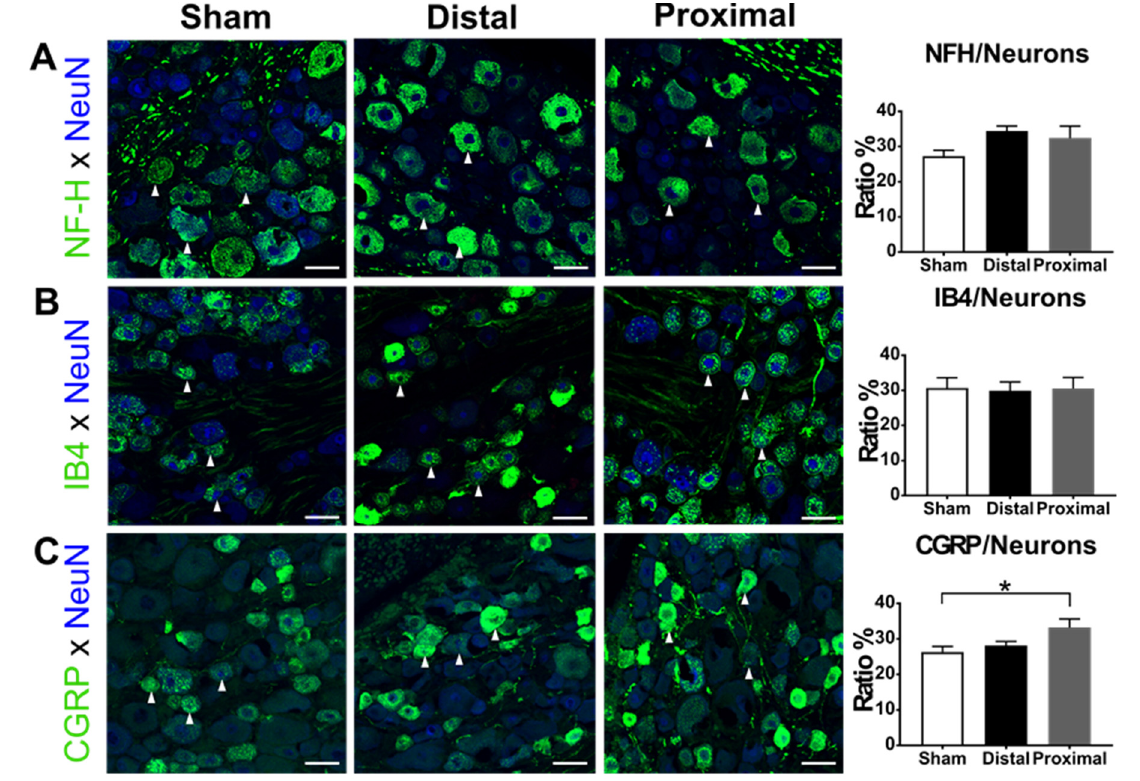
Figure 5. The subpopulation of DRG neurons 1 day after the operation. The ratios of ( A ) NFH, ( B ) IB4, or ( C ) CGRP-positive (arrowheads) DRG neurons of animals with distal nerve constriction (Distal), proximal nerve constriction (Proximal), or sham operation (Sham). Data are mean ± SEM, N =6 in each group. * p < 0.05, scale bar = 50 μ m.